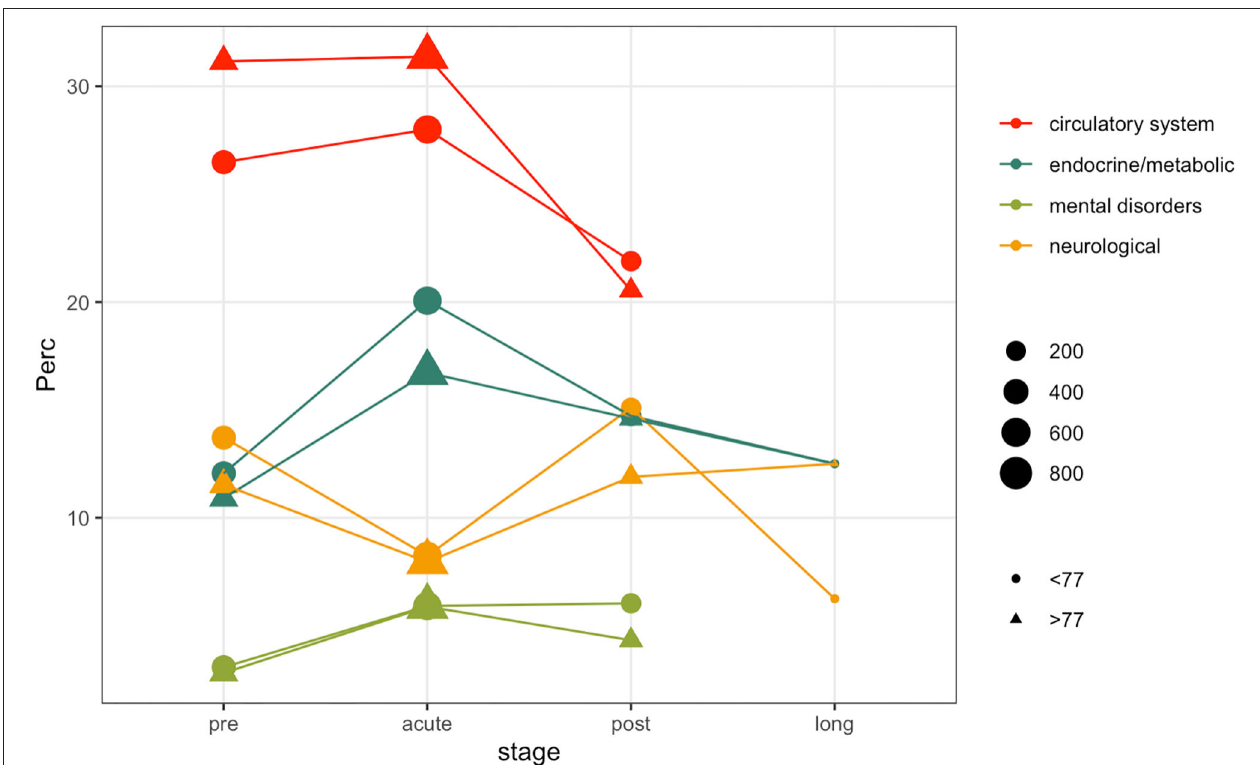
FIGURE 4 | Comorbidity phenotypes prevalence in disease stages stratified by